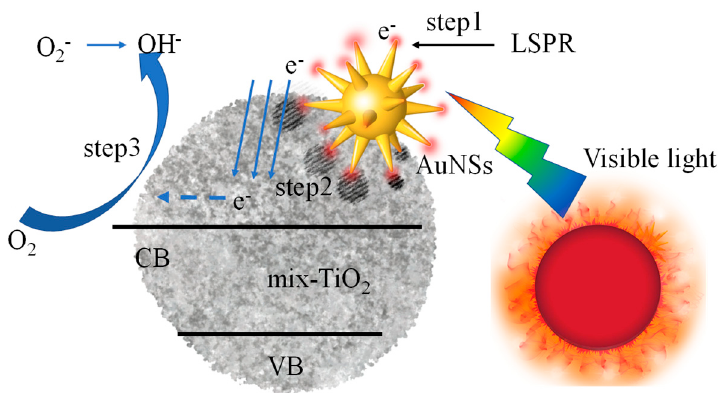
Figure 8. Schematic diagram of the mechanism of photocatalytic degradation of methylene blue by AuNSs@mix-TiO 2 .VB: valence band; CB: conduction band; LSPR: localized surface plasma